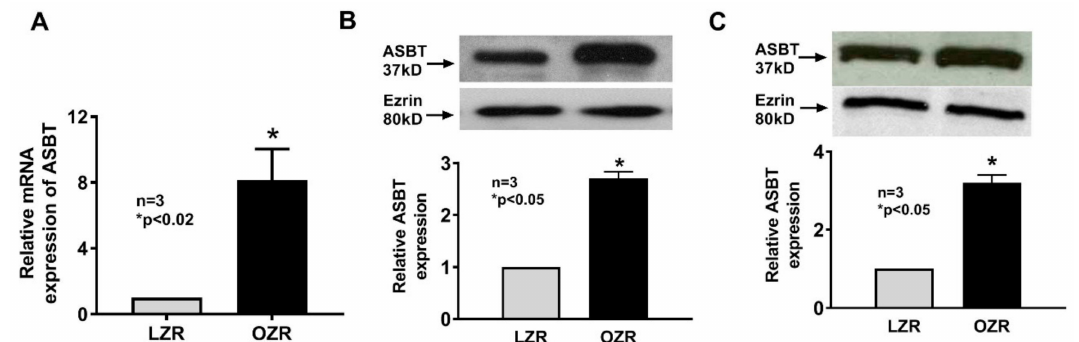
Figure 3. E ff ect of obesity on ASBT expression in Zucker rat villus cells. ( A ) ASBT mRNA expression was significantly increased in distal ileal villus cells from OZR compared to LZR. ( B ). ASBT protein levels were significantly increased in whole villus cell protein extract from OZR compared to